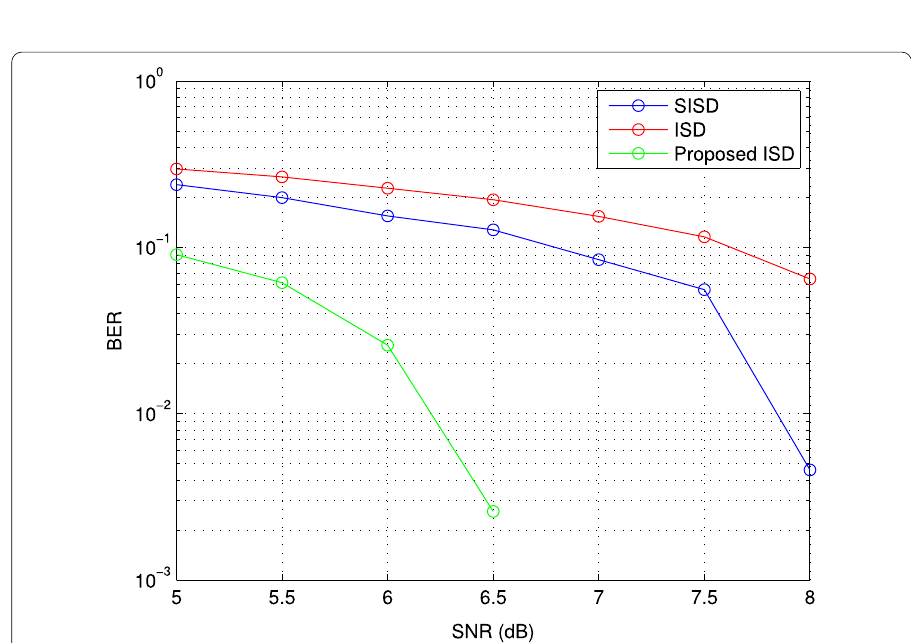
Fig. 4 BER performance comparison against SNR (dB), where the number of signal blocks is d number of continuous time slots is J